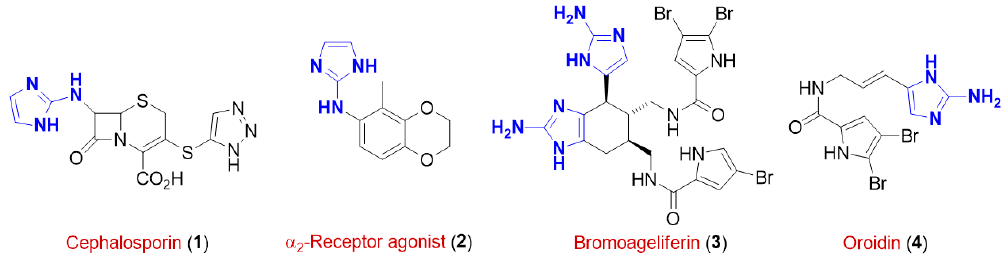
Figure 1. Structural formulas of some pharmacologically-relevant 2-aminoimidazoles.